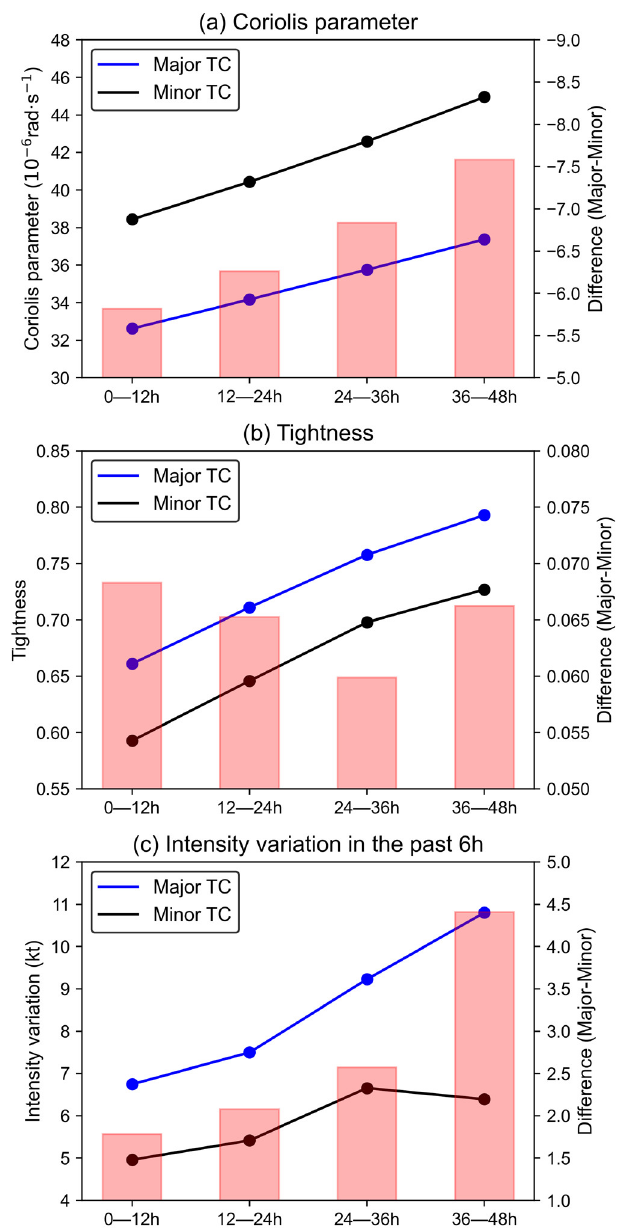
Figure 11. Composite evolution of critical TC state features (blue and black lines) of ( a ) Coriolis parameter (F), ( b ) tightness (TI), and ( c ) intensity variation in the past 6 h (DV6) and their corresponding differences between major and minor TCs (red bars) during first 48 h after genesis. Except for first three intervals in ( c ), differences of all intervals are significant at a confidence level of 99%.